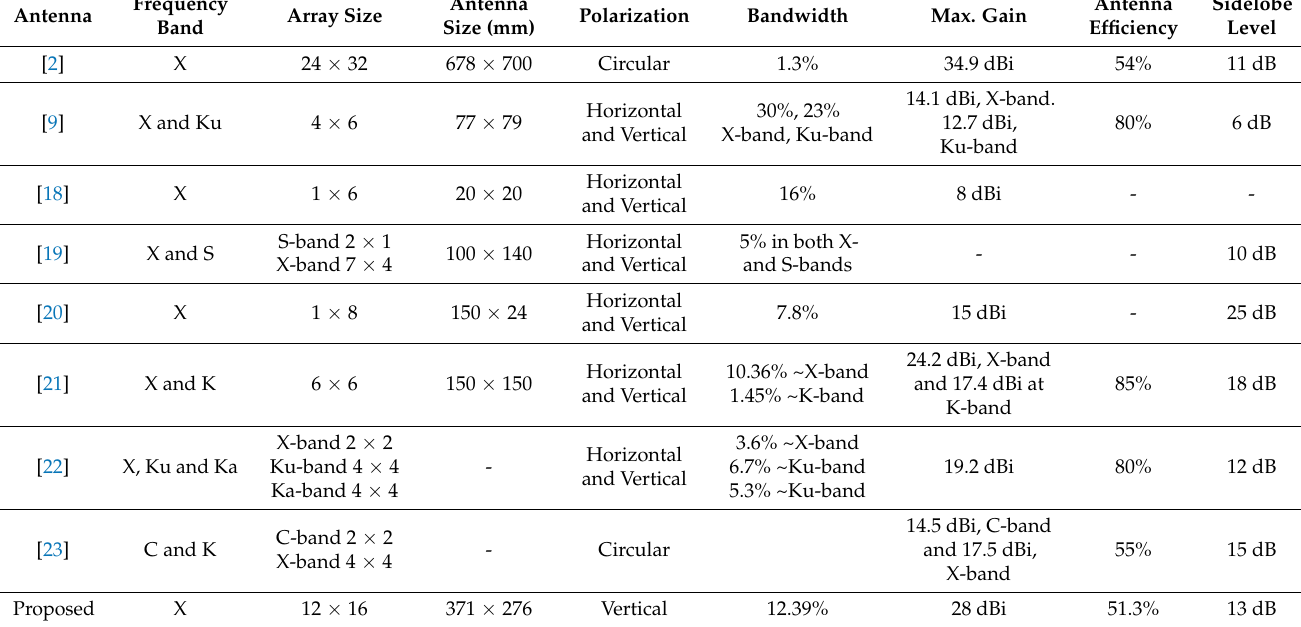
Table 1. Comparison of proposed antenna with some previously reported X-band SAR array anten- nas.